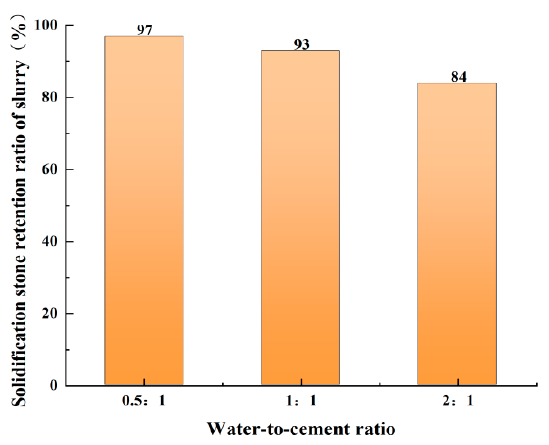
Figure 4. Stone solidification retention ratio of slurry in static environment.